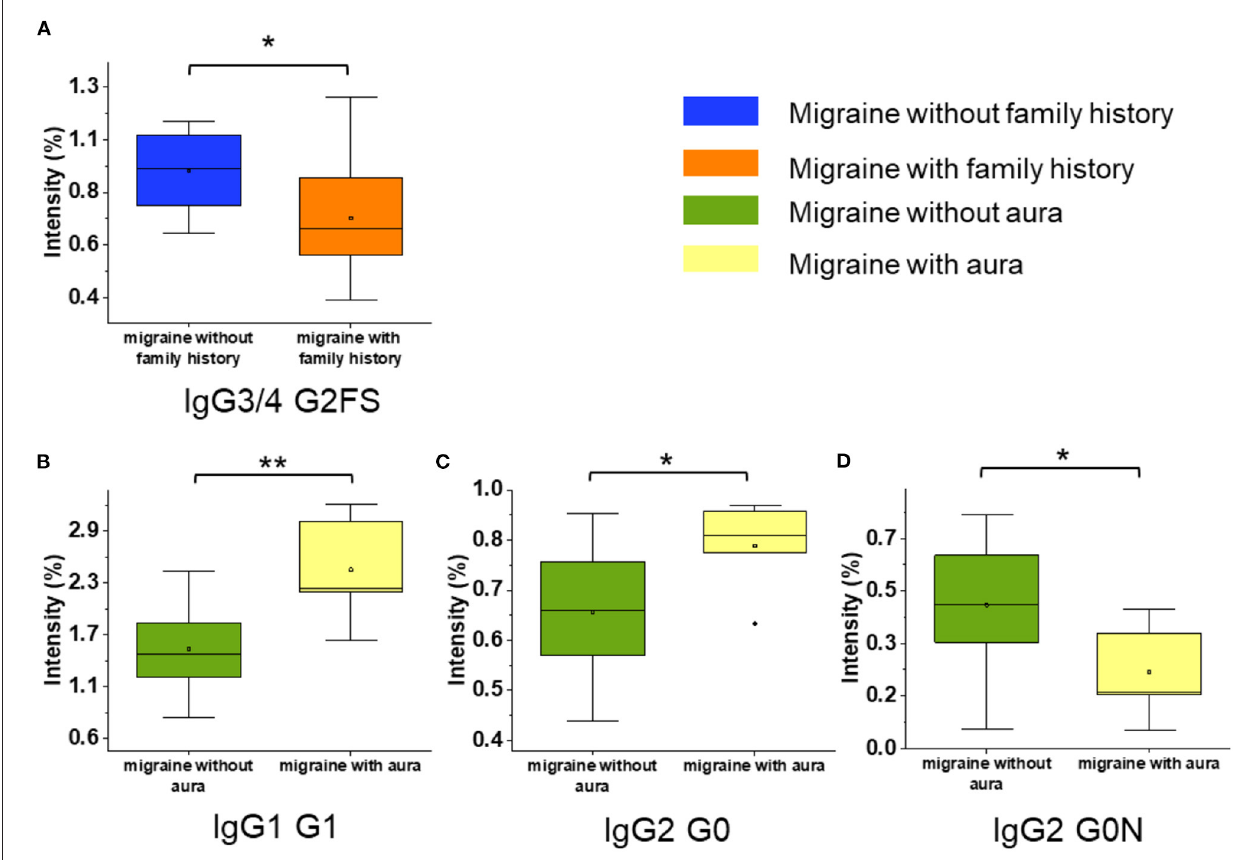
FIGURE 4 | The serum level of IgG glycopeptides in the different migraine subgroups and phases. (A) The serum level of IgG3/4 G2FS of migraine with and without family history ( n = 11/9). (B–D) The serum level of IgG glycopeptides of migraine with and without aura ( n = 5/15). The level of IgG glycopeptides was presented as box plots showing median values, upper and lower quartiles, as well as the whole range for patients and controls. The glycan species were named as G0, G1, and G2 according to the numbers of galactoses, F, fucose; S, sialic acid; N, N-acetylglucosamine. * p < 0.05, ** p <